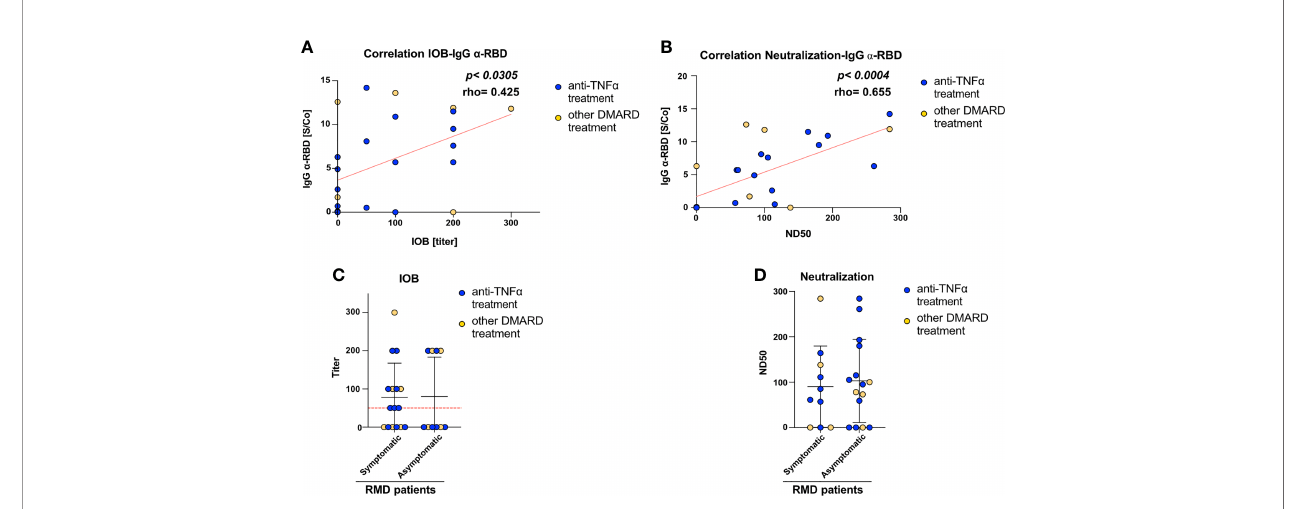
FIGURE 2 | RMD patients elicit anti-SARS-CoV-2 neutralizing antibodies. Correlation between (A) IOB and (B) ND50 (neutralization dose 50 vs. anti-RBD IgG levels in RMD patients at T1. In the graph, samples from anti-TNF a -treated patients are marked by color code. The p -value and correlation coef fi cient rho were calculated using non-parametric Spearman correlation. (C) Inhibition of binding of recombinant RBD protein to HuH7.5 cell line expressing hACE2 by sera of RMD patients strati fi ed by occurrence of COVID-19 symptoms. (D) Neutralization of infection with SARS-CoV-2 pseudoparticles of RMD patients ’ sera, symptomatic and asymptomatic, were tested for their ability to neutralize pseudotyped viral particle infection. Samples from anti-TNF a -treated patients are marked by color code. N = 26. Statistical signi fi cance was determined using two-tailed Mann – Whitney